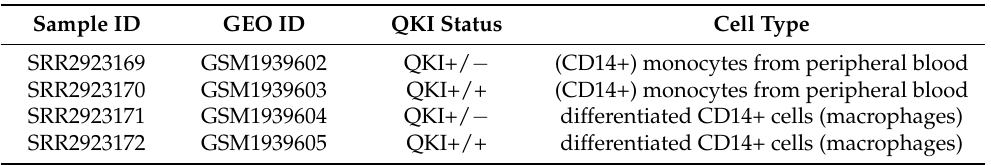
Table 3. Sequence Read Archive (SRA) and Gene Expression Omnibus (GEO) accession numbers, genotype, and cell type of the samples analyzed in the demonstrative analysis. Sample